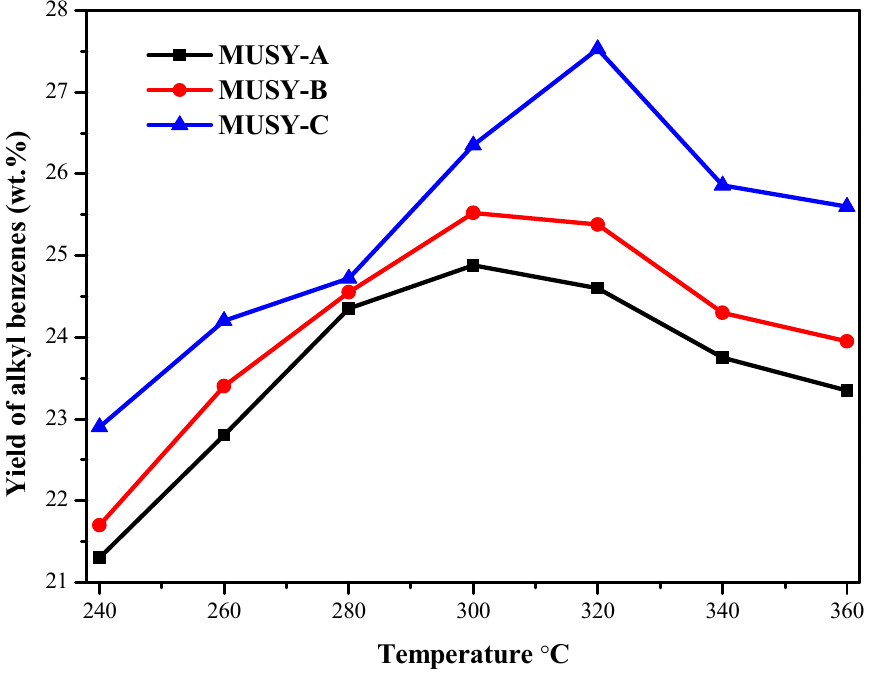
Figure 6. Effect of temperature on the yield of alkylbenzenes in the hydrocracking products over the catalysts containing MUSY-A, MUSY-B, and MUSY-C.